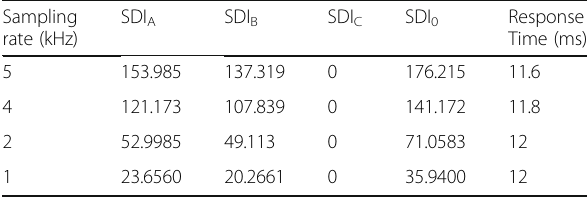
Table 6 SDI values during different sampling rate